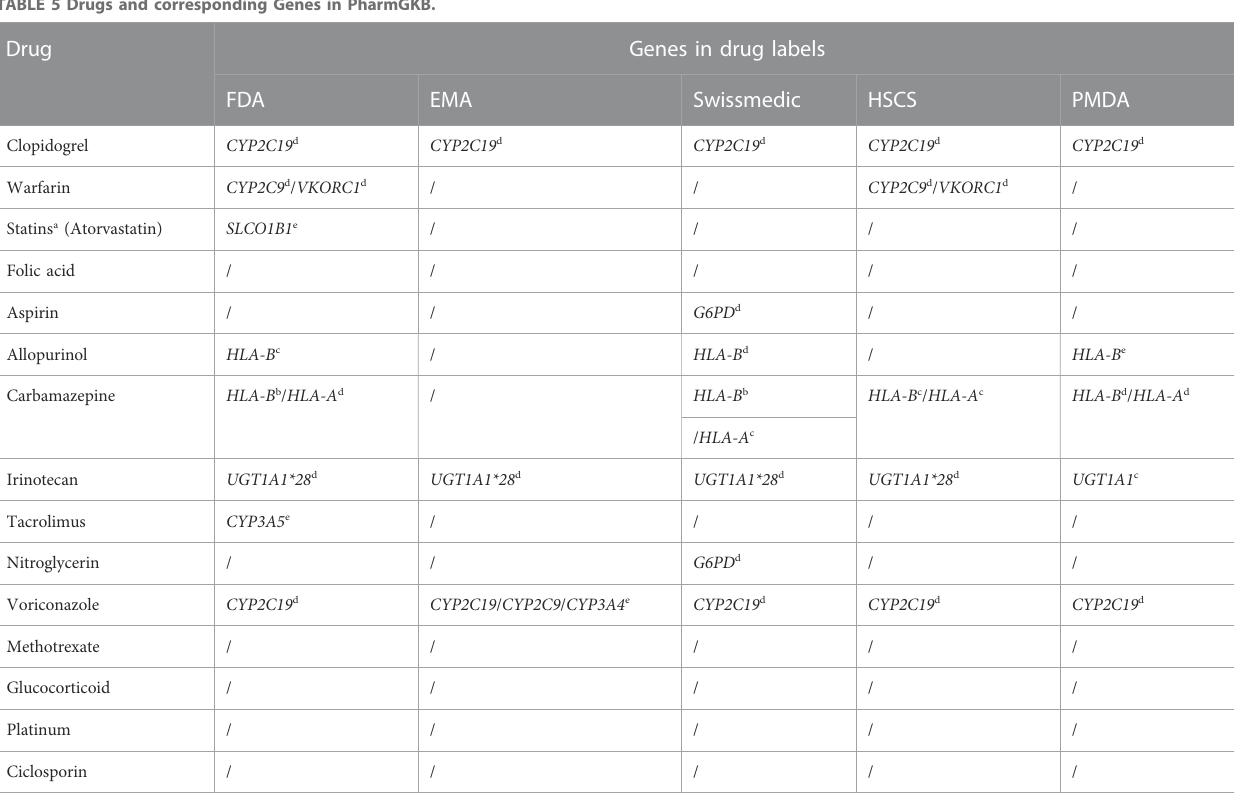
TABLE 5 Drugs and corresponding Genes in